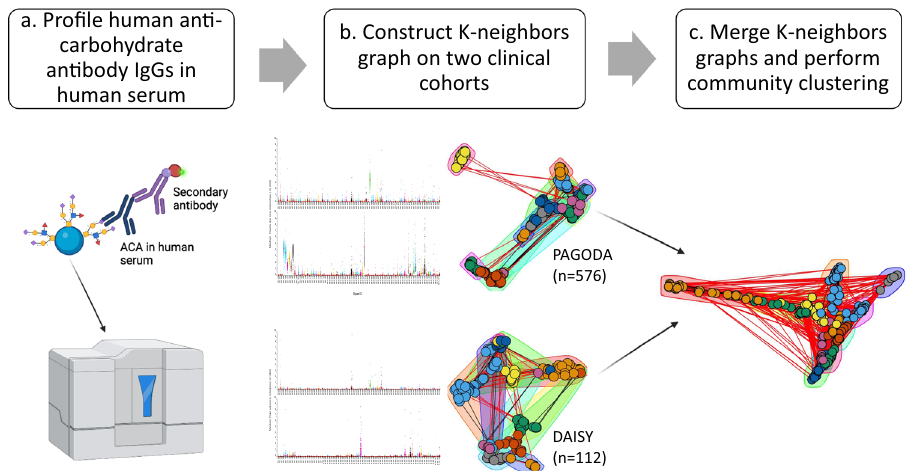
Fig. 1 | Community clustering of 201 glycans in serum samples from 688 par- ticipants identify 11 major clusters. a Overview of multiplex glycan suspension array platform and methodology. Brie fl y, diluted human serum is added to a mix- tureof fl uorescentbeadseachlinkedtoadifferentglycanstructuretoallowhuman anti-carbohydratedantibodies(ACAs)tobindtotheimmobilizedglycans.Abiotin- conjugated anti-human IgG antibody is added. Finally, streptavidin-conjugated phycoerythrin is added and the median fl uorescence intensity is measured on a Luminex instrument. Created with BioRender.com. b Distribution of ACAs in the Diabetes Autoimmunity Study (DAISY) and Phenome and Genome of Diabetic Autoimmunity (PAGODA) shown as median fl uorescence intensity dot